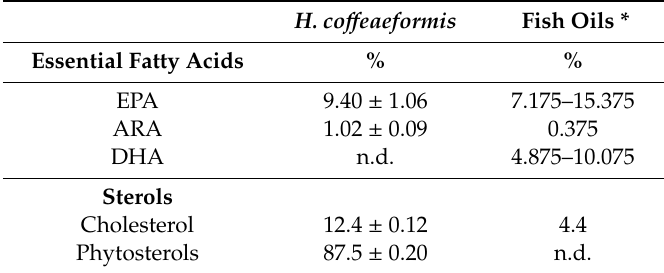
Table 3. Main lipid species relevant for aquafeeds. The percentages of lipids found in H. co ff eaeformis are compared with those found in fish oils used for aquafeed according to